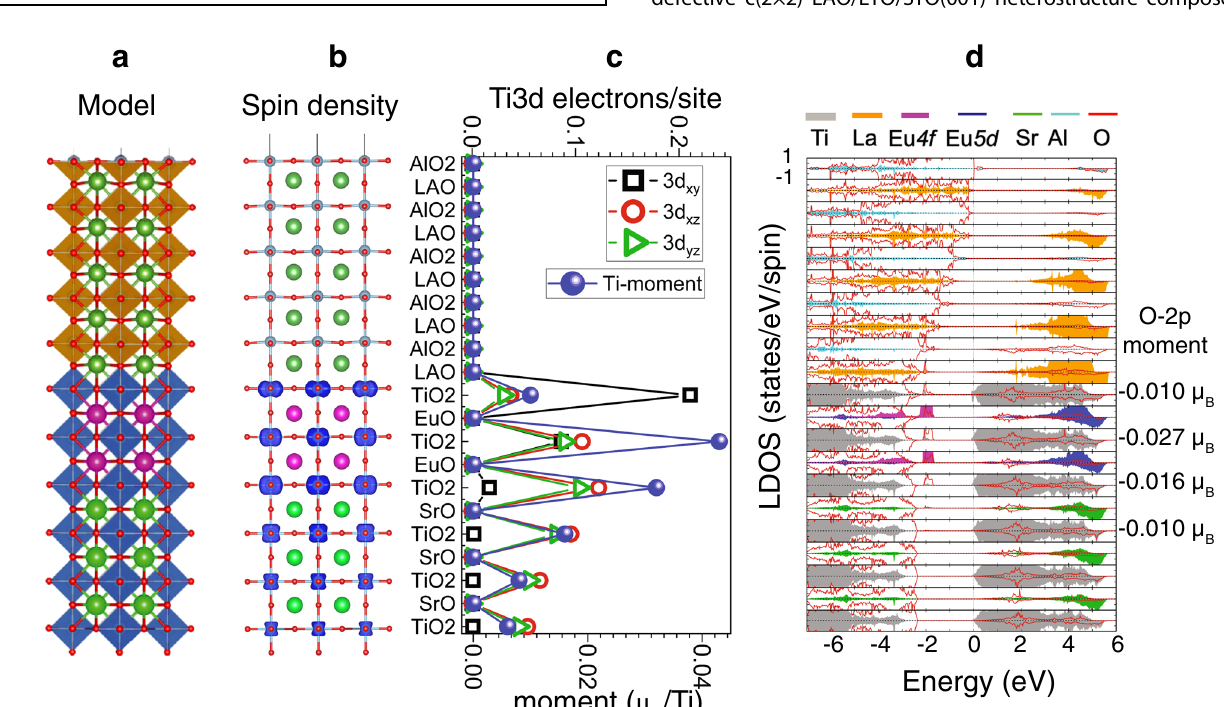
Fig. 5 DFT + U calculations. a Side view of the simulated c(2×2) LAO/ETO/STO(001) heterostructure; b spin density, integrated between − 0.3 eV and E 3 , showing the spatial distribution of the 2DEG and the orbital character at the Ti sites; c orbital and F , with isovalue of 0.0004 e/Å layer resolved Ti-3d occupation (upper scale; black squares, 3d xy ; red circles, 3d xz , green triangles, 3d yz ) and Ti-3d magnetic moment (lower scale; blue circles) obtained by integrating the density of states between − 0.3 eV and E F . d Layer-, spin- and element- resolved density of states. The color code for the partial LDOS contribution of different ions is indicated on top of the fi gure. On the right side of the fi gure, we also indicate the values of the calculated oxygen-2p magnetic moment in the corresponding interfacial TiO 2